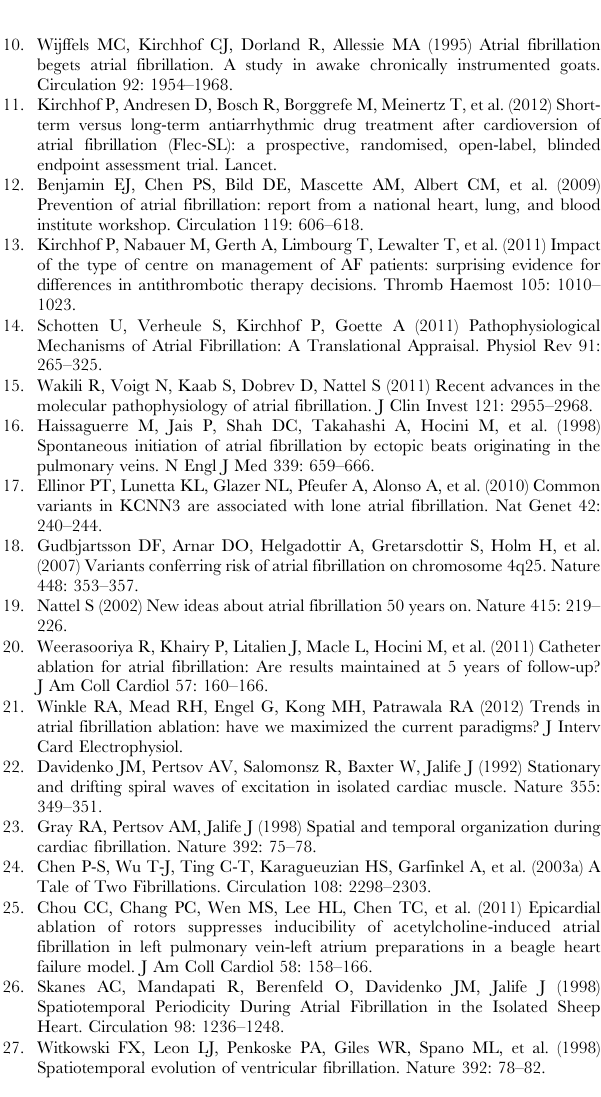
correlation at each site of the direction over consecutive cycles, showing high recurrence (repeatability) in the annulus adjacent to the rotational center (warm colors) with markedly reduced correlation in a surrounding annulus of tissue (cool colors) with some recovery of repeatability at distant sites. (TIF) Figure S3 Temporal Conservation of a Left atrial rotor in human AF for 237 days. A . Isochronal map of a left atrial rotor obtained prior to conventional ablation that passed outside this source, and did not target it. Atrial fibrillation failed to terminate during ablation, and recurred after the procedure. B . Isochronal map of a left atrial rotor at the same location obtained at repeat electrophysiology study 237 days later. Targeted ablation at this source eliminated AF. Figure S4 Additional Examples of Brief Targeted Abla- tion at Stable Sources for Human Atrial Fibrillation. A . Isochronal map of a left atrial focal beat source that lay outside traditional ablation lesion locations. Localized ablation at this site (red dot, and contiguous white dots) terminated AF directly to sinus rhythm in , 5 minutes. B . Isochronal map of a counter-